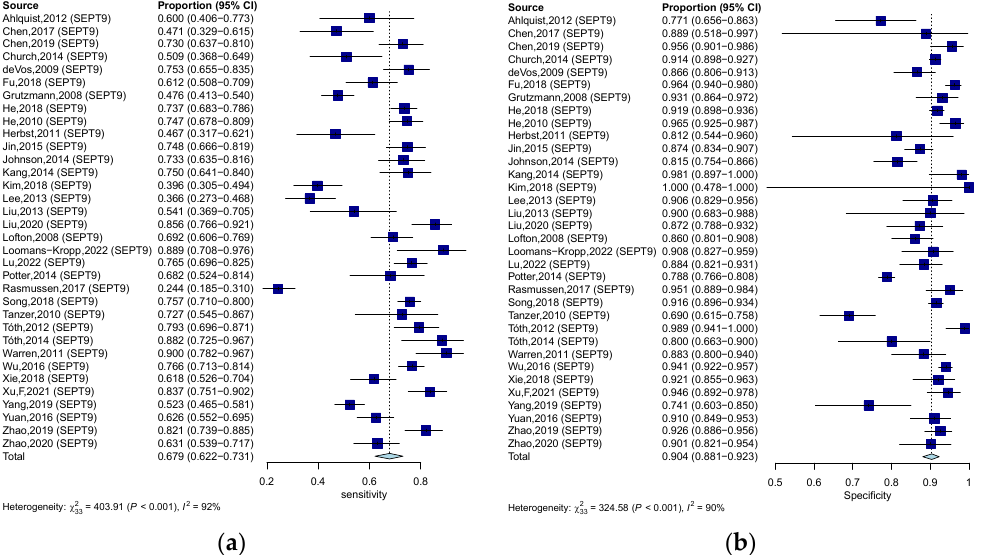
Figure 6. Forest plots of SEN ( a ) and SPE ( b ) for diagnostic value of ctDNA assay for CRC in the SEPT-9 methylation detection subgroup. 95% CI, 95% confidence interval; CRC, colorectal cancer; ctDNA, circulating tumor DNA; SEN, sensitivity; SPE, specificity; diamond shapes representing average effect; dark blue squares representing individual study results.